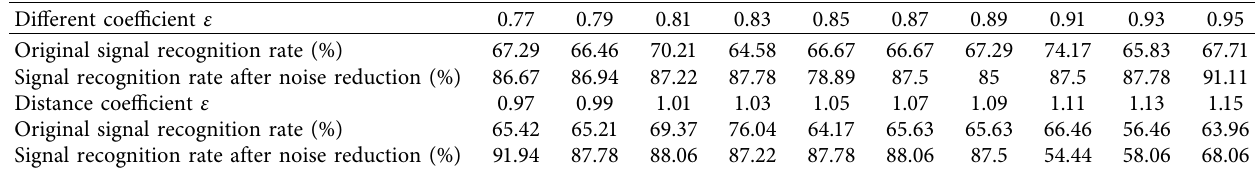
Figure 22: Recognition rate of four fault status signals before and after noise reduction. Table 3: Recognition rate under different distance coefficient ε .